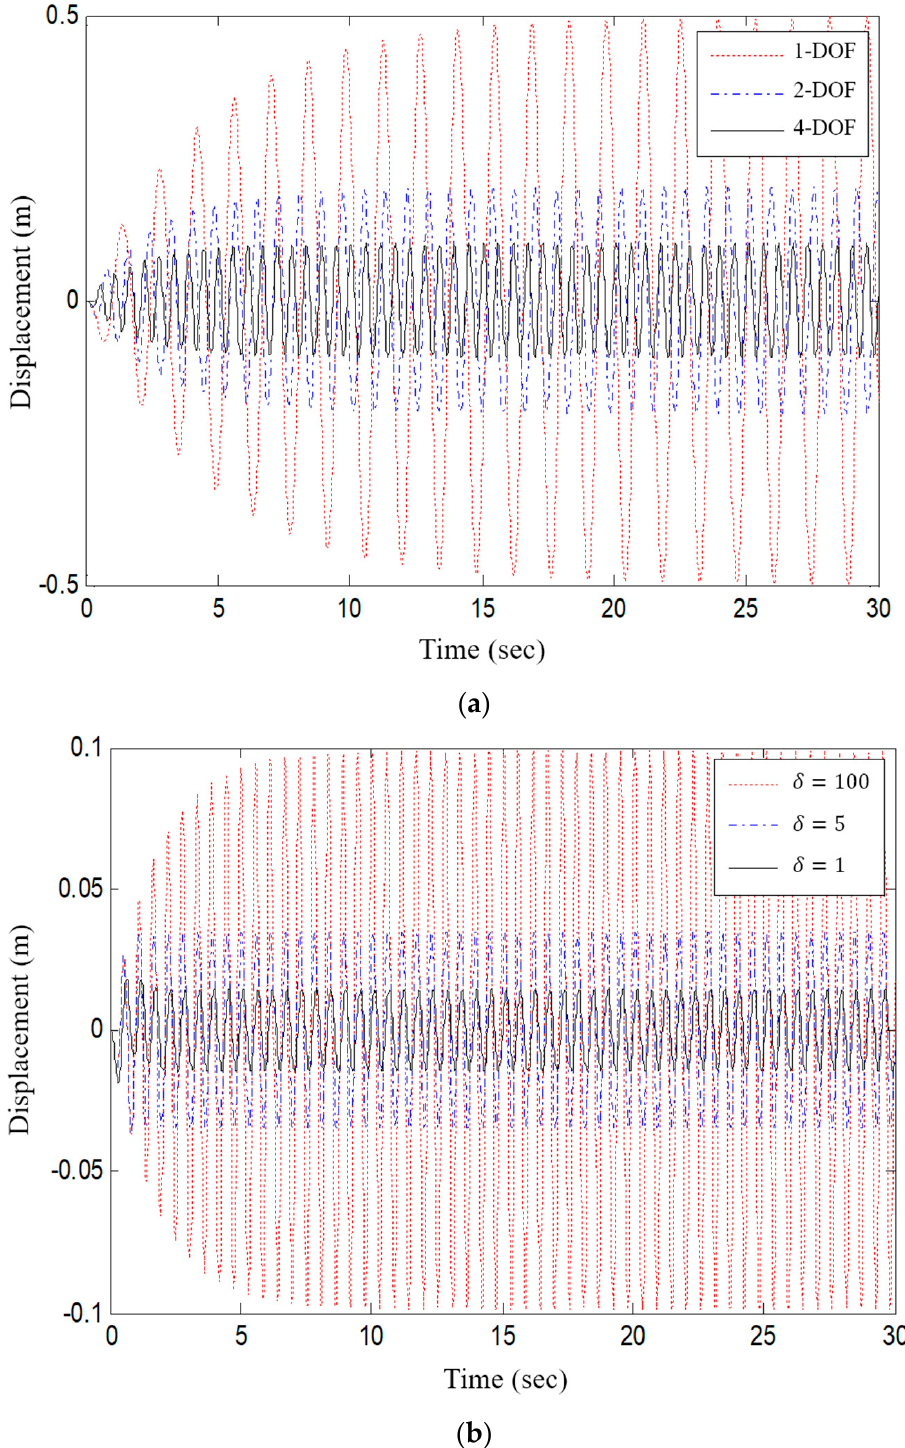
Figure 14. Displacement responses. ( a ) Harmonic excitation ( ξ = 0.05, δ = 100); ( b ) 4-DOF structure by δ ( δ = 0.56, ξ = 0.05).